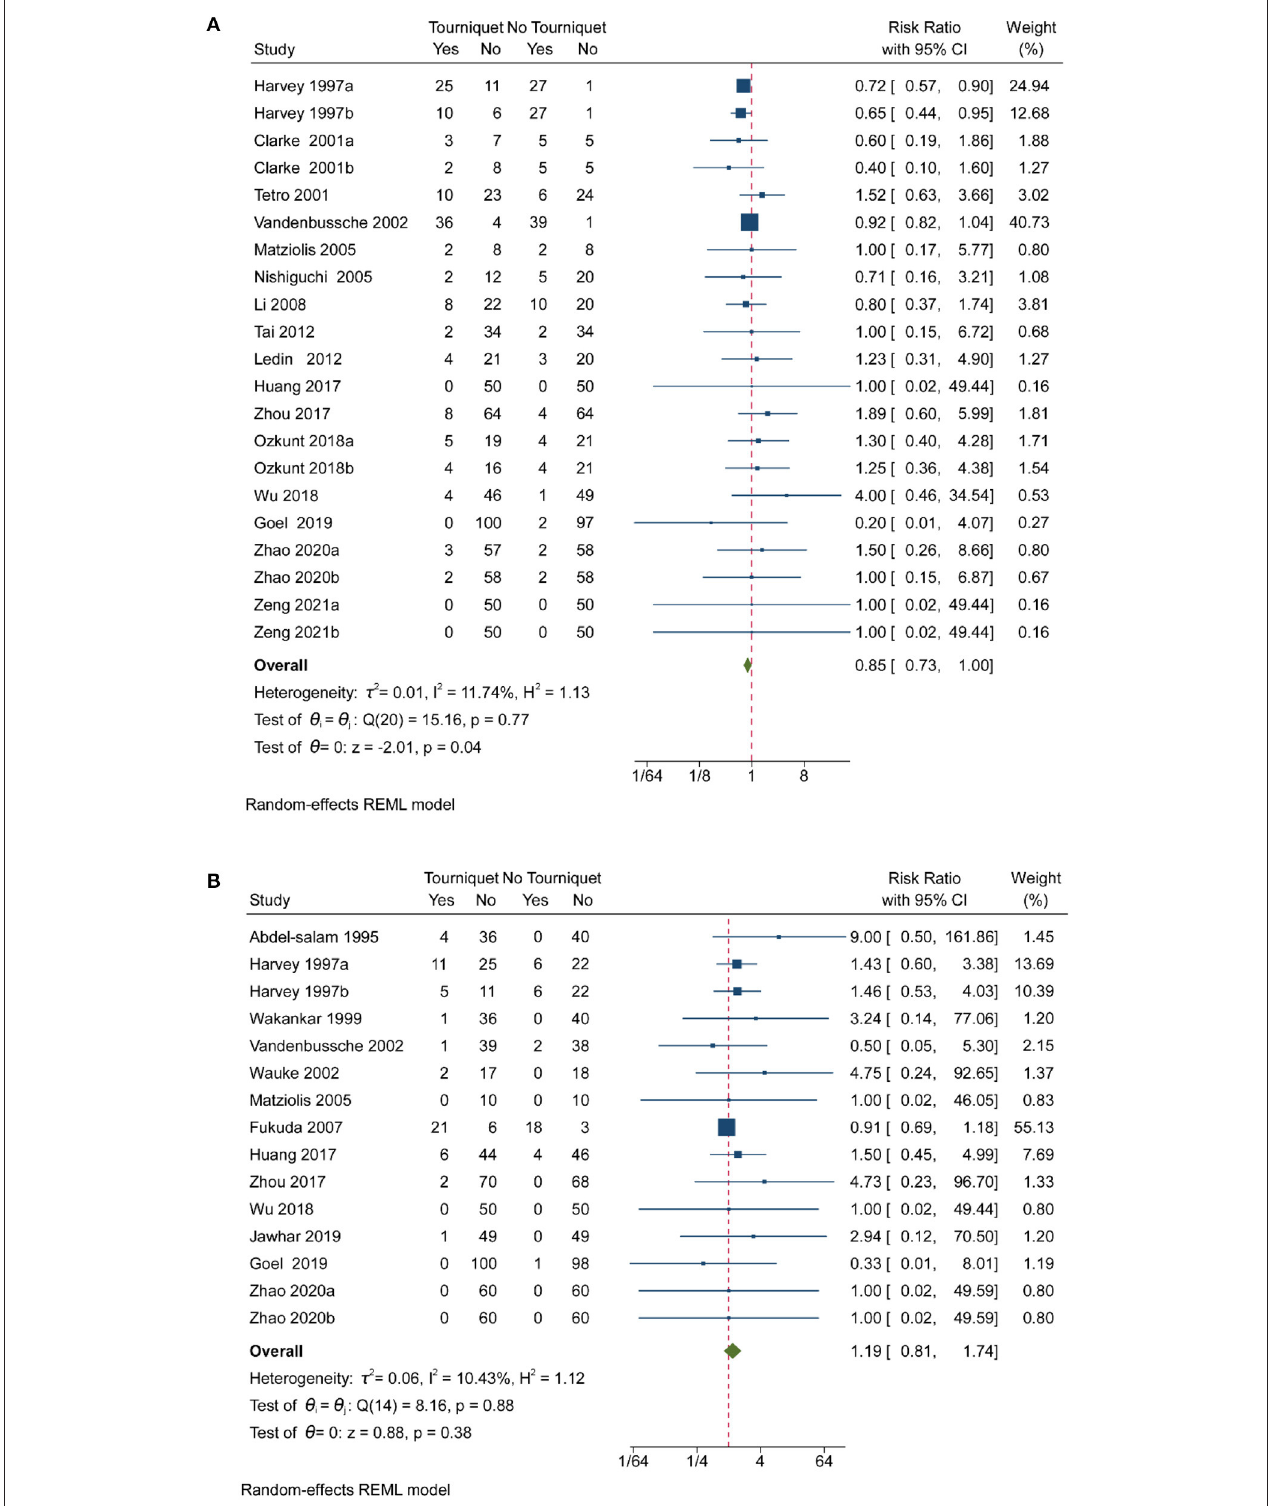
FIGURE 4 | Forest plot for transfusion rate and DVT. (A) Forest plot comparing transfusion rates between no tourniquet and tourniquet groups; (B) Forest plot comparing DVT outcomes between no tourniquet and tourniquet groups.